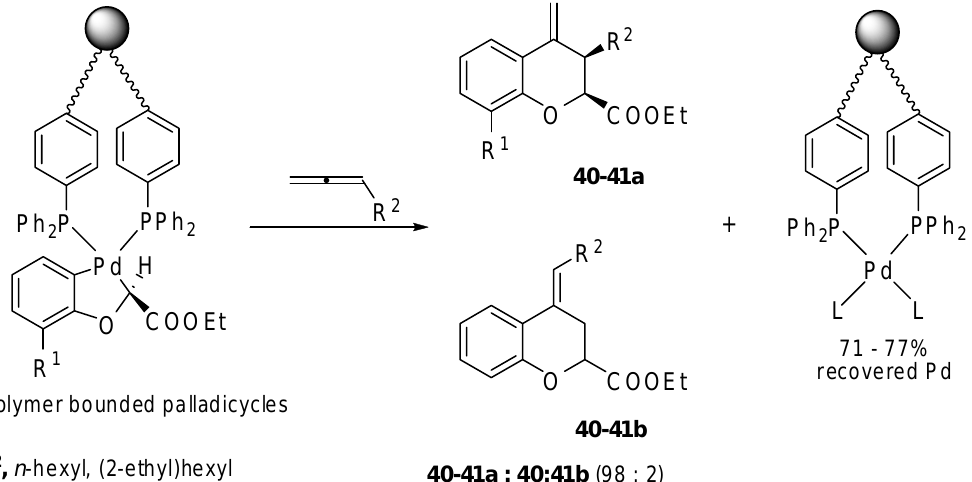
Scheme 19. Synthesis of 2,3-disubstituted 3,4-dihydro-2 H -1-benzopyrans using a polymer bounded palladicycle.